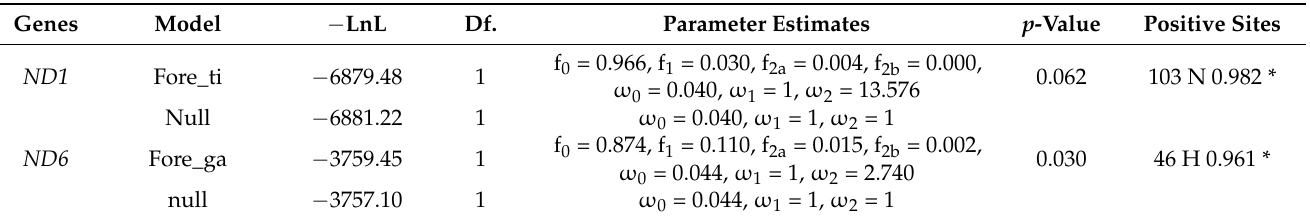
Figure 5. Divergence time tree of the glyptosternine catfishes derived from the partitioned Bayesian analysis using the relaxed molecular clock method in BEAST. Numbers on nodes (in brackets) indicate the 95% highest posterior density interval of divergence time. Table 3. Analysis based on the branch-site models for protein-coding genes of three Exostoma